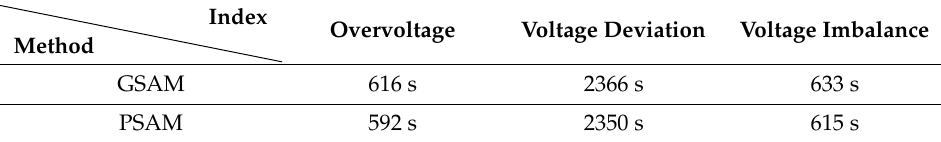
Figure 10. PV installation scenario combinations for the di ff erent methods. Table 2. Computational time of di ff erent